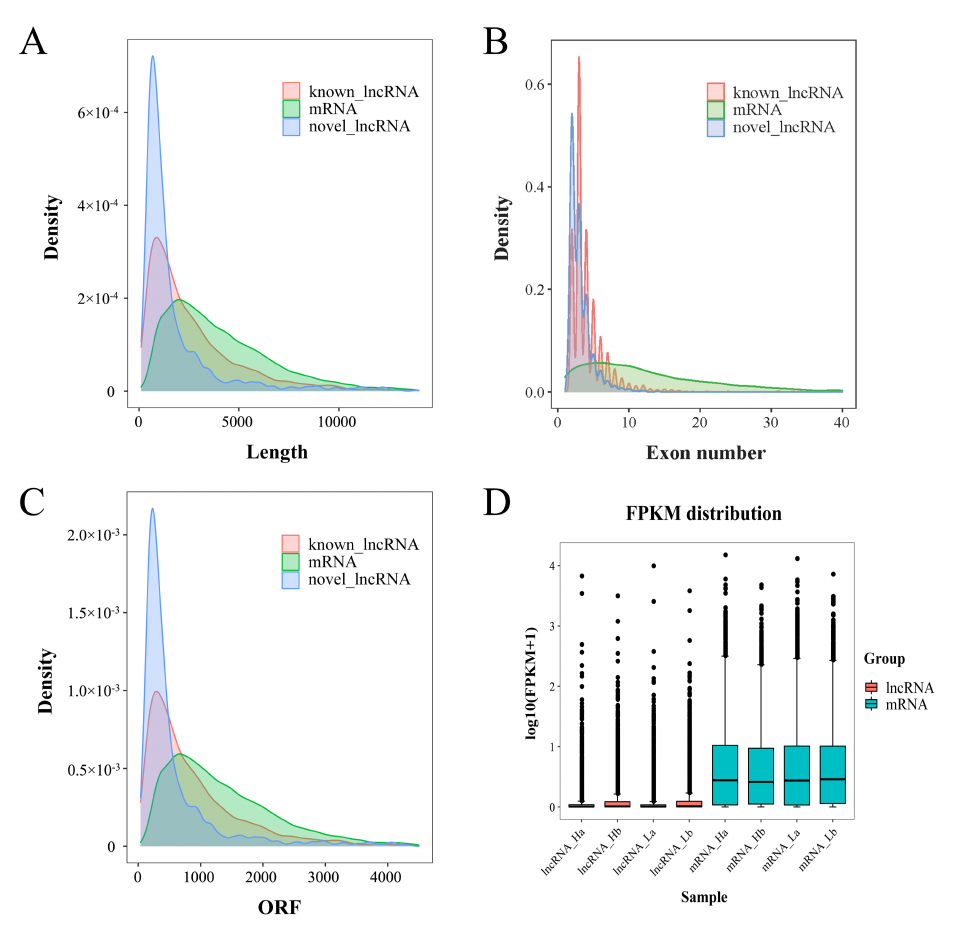
Figure 3. Genomic characteristics of lncRNA and mRNA in pig testes: ( A ) Length distribution of 9282 known lncRNAs (red), 21,674 mRNAs (green), and 1424 novel lncRNAs (blue); ( B ) exon number distribution of lncRNAs and mRNAs; ( C ) ORF length distribution of lncRNAs and mRNAs; ( D ) box plots showing the expression levels {log 10 (FPKM+1)} of lncRNA and mRNA in Ha, Hb, La, and Lb